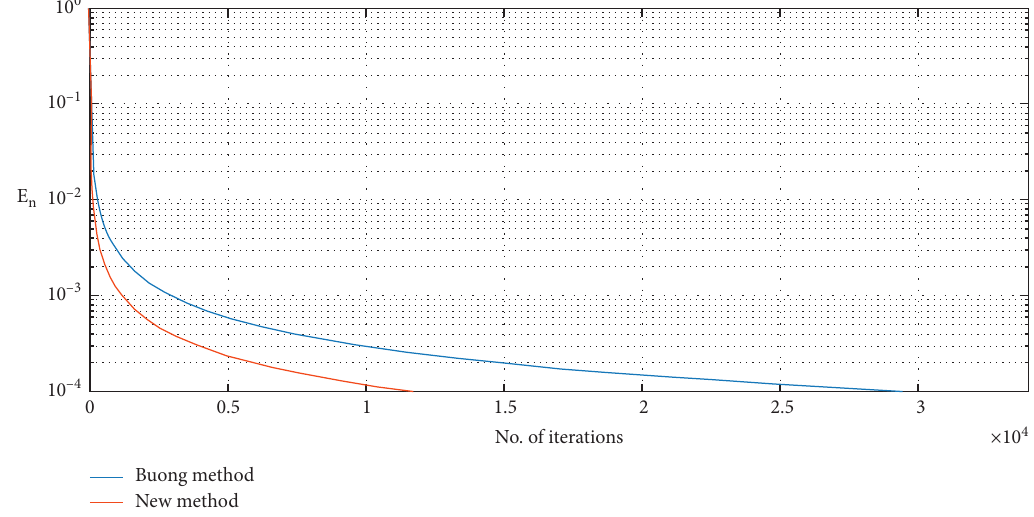
Figure 1: The convergence behavior of E